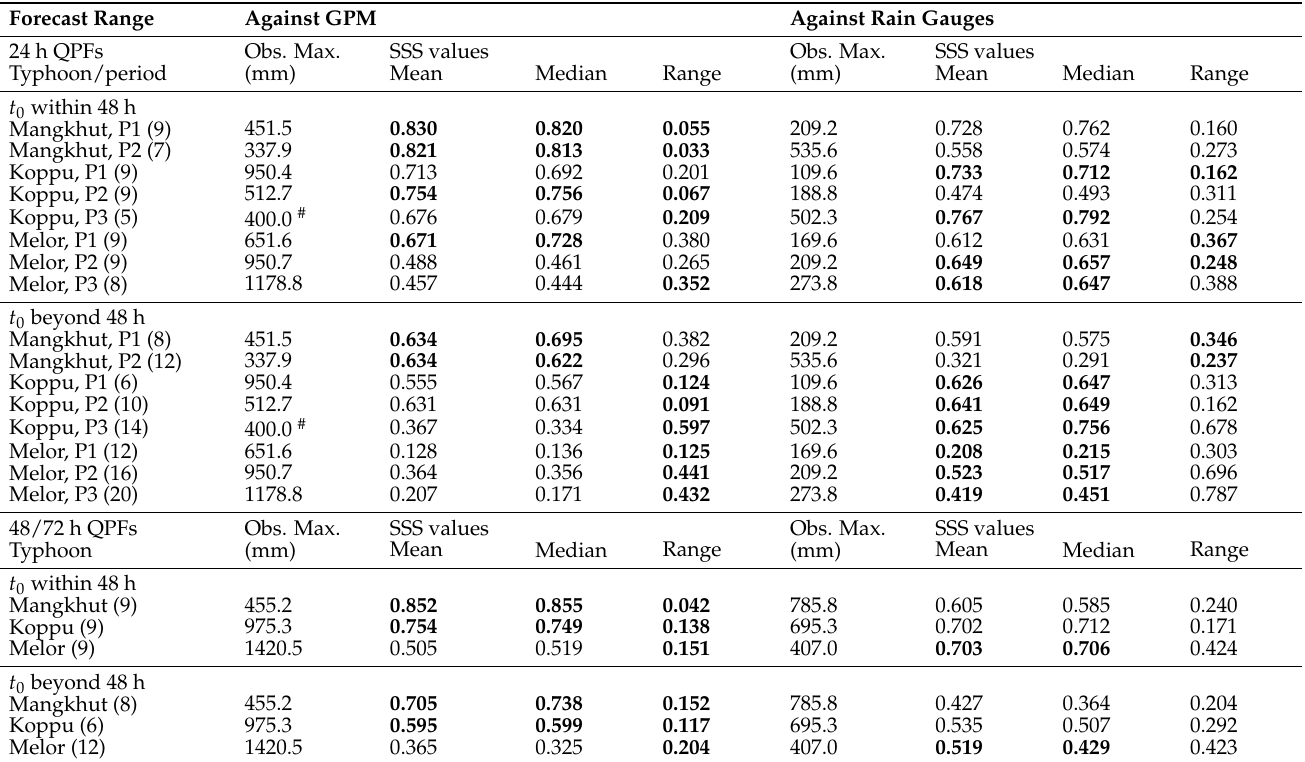
Table 5. Comparison of mean, median, and range of SSS values with the CReSS hindcasts for the three typhoons against the GPM retrievals (left) and the rain gauges (right) in each category: 24 h QPFs over small domains for selected periods of P1, P2, and P3 (top) and 48 h or 72 h QPFs for entire events over the large domain (bottom), within the short range ( t 0 ≤ 48 h before the beginning of accumulation) and beyond. All the periods shown are the same as those in Sections 4–6, and the number of lagged runs is given in the parentheses. Bold faces indicate the better result between the two data sources (higher mean/median but smaller